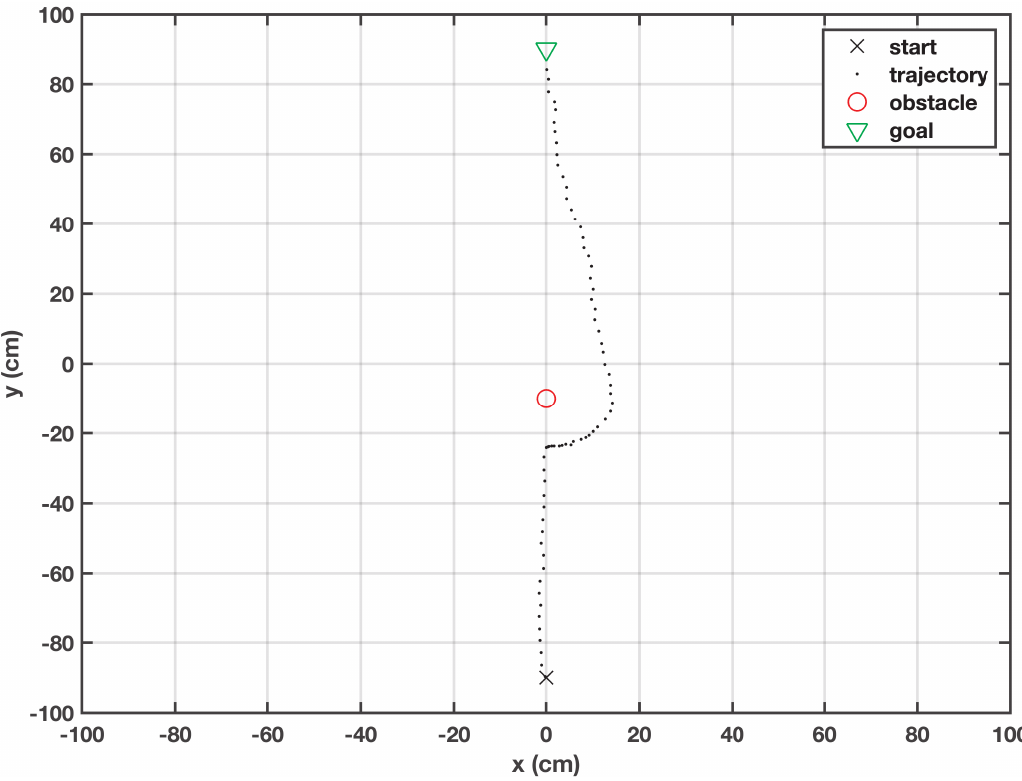
Figure 5. Trajectory of the robot when the obstacle lies straight